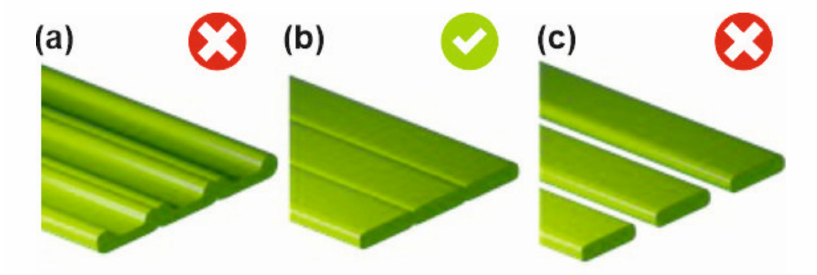
Figure 5. Beads building up a solid layer: ( a ) the extruded amount is too high (over-extrusion); ( b ) the bead height, the printing speed, and the extruded amount are well-balanced; ( c ) the extruded amount is too low (under-extrusion) to create a closed